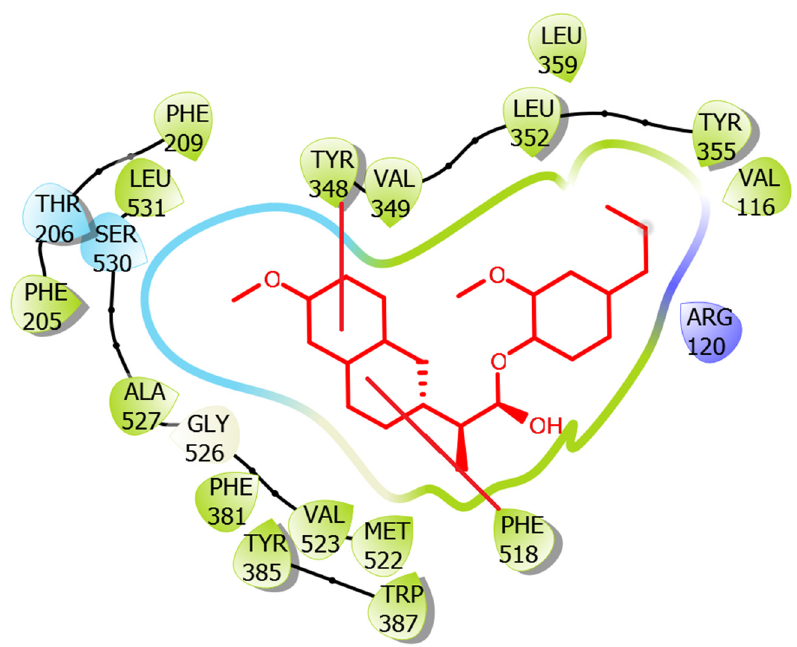
Figure 6. Two-dimensional ligand interactions of MAS1696 with human COX2 enzyme.